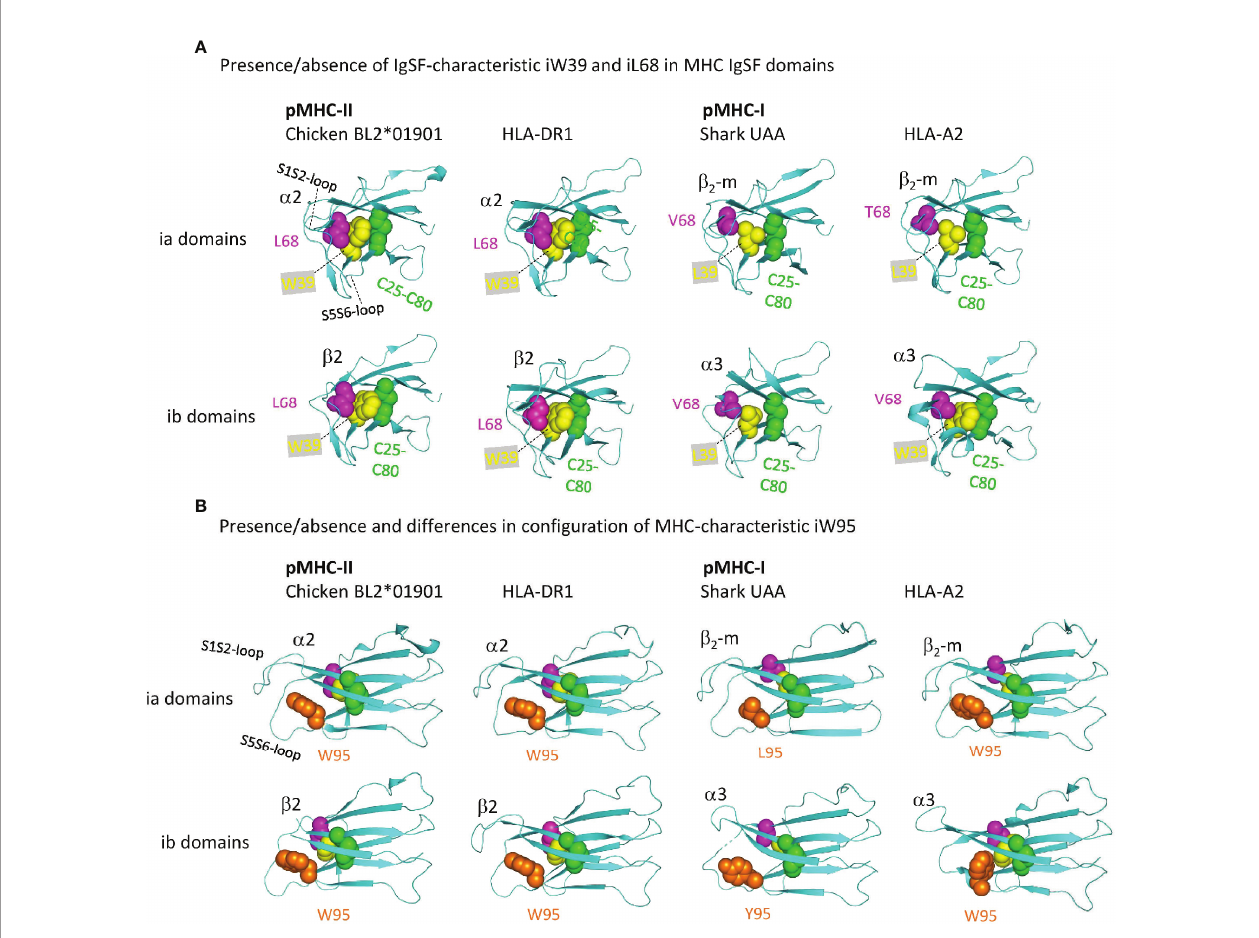
FIGURE 11 | Representative MHC IgSF domains with the structurally important residues iC25-iC80 cysteine pair, iW39, iL68, and iW95, or their replacements. Highlighted residues are shown with individual colors per position and with spheres format presentation for sidechains. (A, B) Are from different angles. Residue coloring in (B) is as in (A) , but In (A) the i95 residues are not